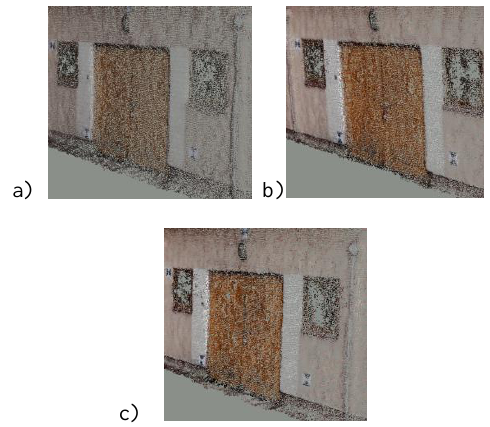
Figure 2. A fragment of the point cloud generated from video frames on unprocessed data (a), (b) data which underwent histogram equalization and variant, (c) data which underwent